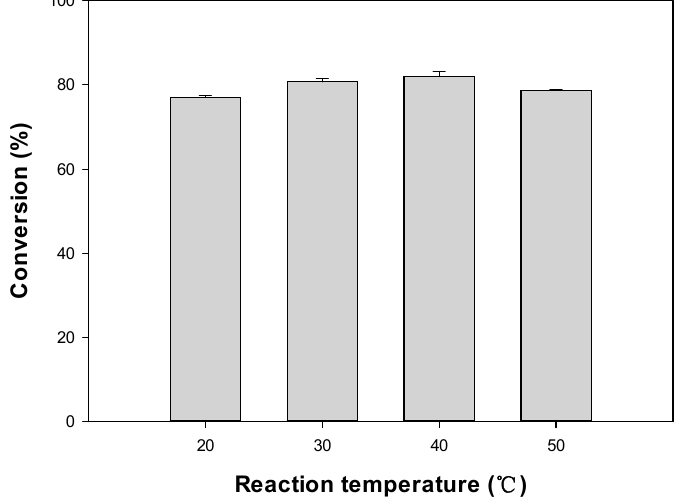
ff ect of reaction temperature on the octyl formate Figure 5. Effect of reaction temperature on the octyl formate conversion. Figure 5. E Figure 5. Effect of reaction temperature on the octyl formate conversion.